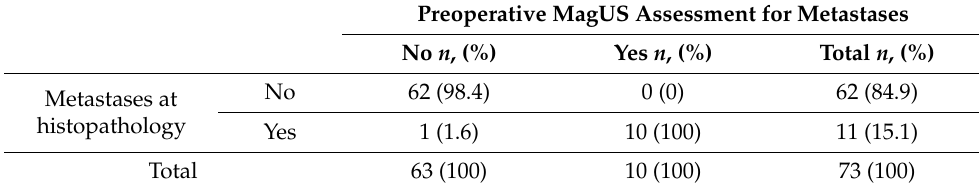
Table 2. Comparison between MagUS and final